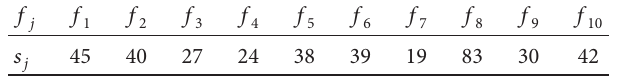
Table 4: Size files values for the case study.